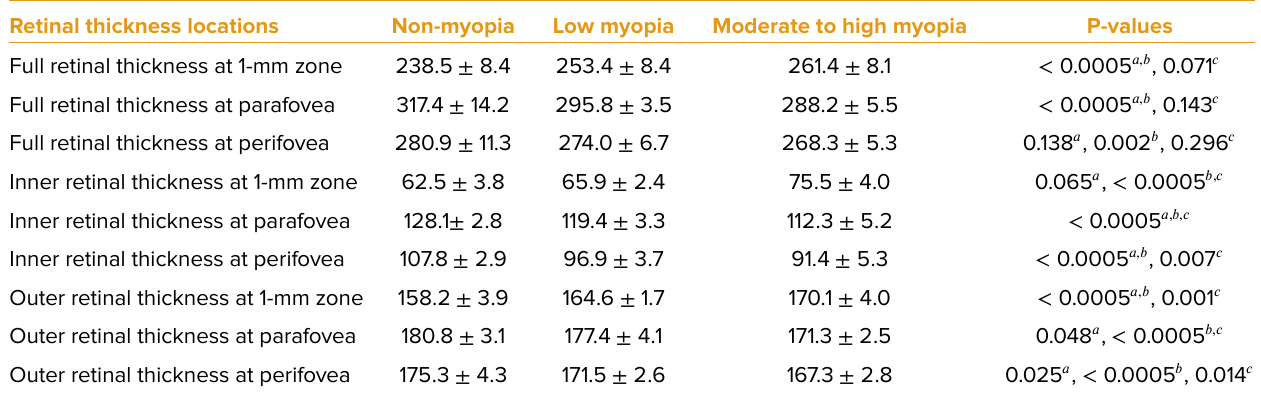
Table 2. Mean retinal thickness measurements (µm) and comparisons between groups at nine locations in non-, low, and moderate to high myopic healthy Saudi participants Retinal thickness